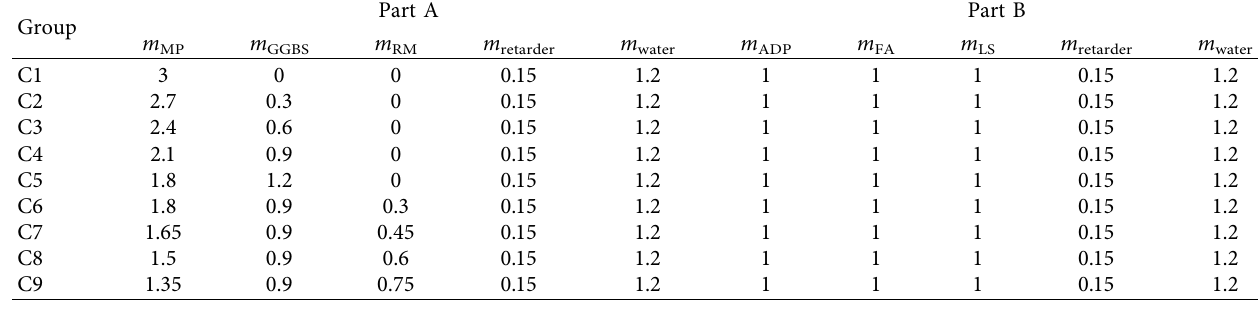
Table 2: Mix proportions of MPC-based grouting materials containing industrial wastes.